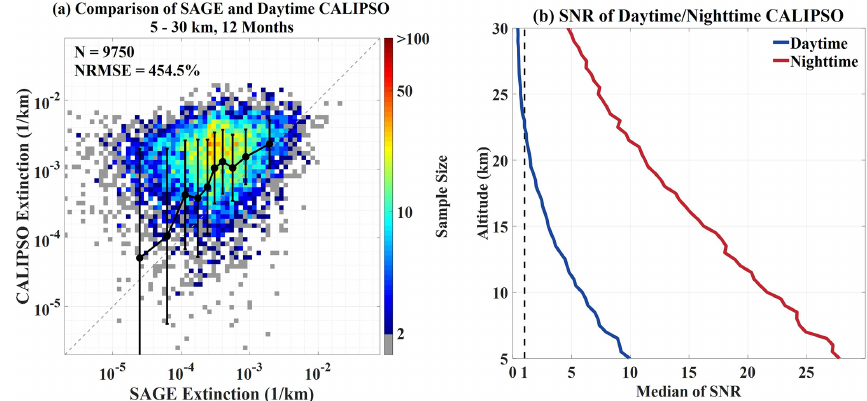
Figure 6. Panel (a) is the same as Fig. 5a but at daytime. (b) SNR profiles of the TAB at 20km horizontal resolution at daytime (blue) and night-time (red). The SNR is calculated according to SNR = µ/σ based on the pre-processed TAB with 20km horizontal resolution in the matching range, where µ and σ are the mean and the standard deviation of the signal, respectively.